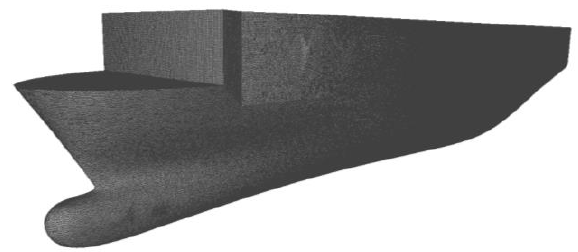
Figure 10. STL hull model of 6750 TEU containership for CFD simulations.